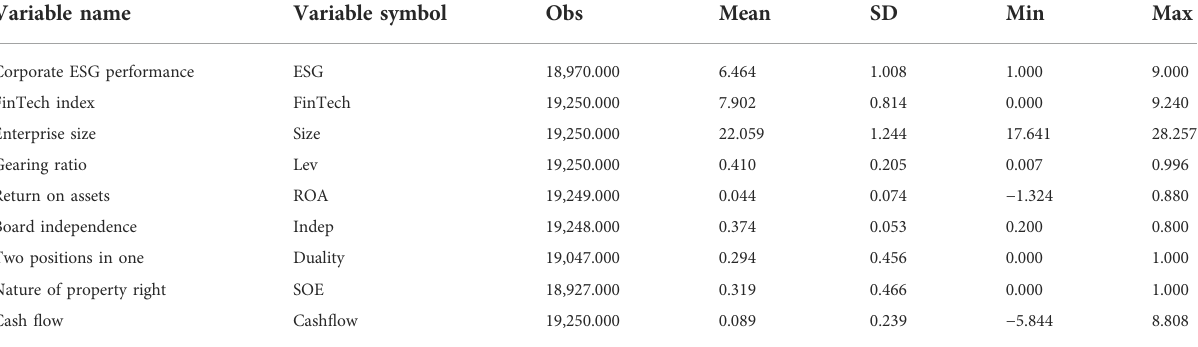
TABLE 2 Descriptive